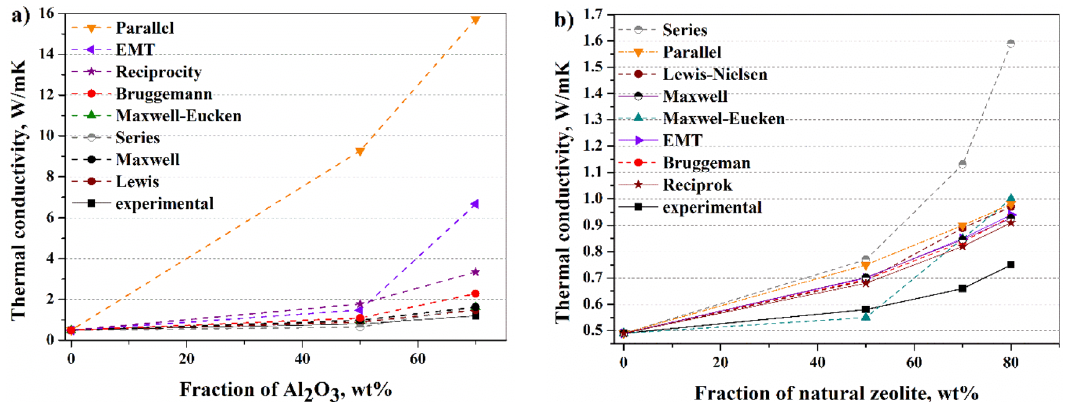
Figure 7. Comparisons between predicted and measured thermal conductivities of Al 2 O 3 ( a ) and natural zeolite ( b ) containing